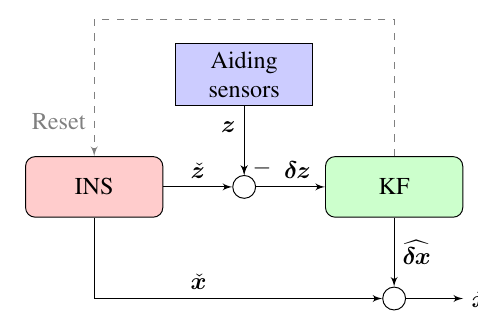
Figure 2: High-level outline of model-aided INS. Both measurements are crucial for the INS